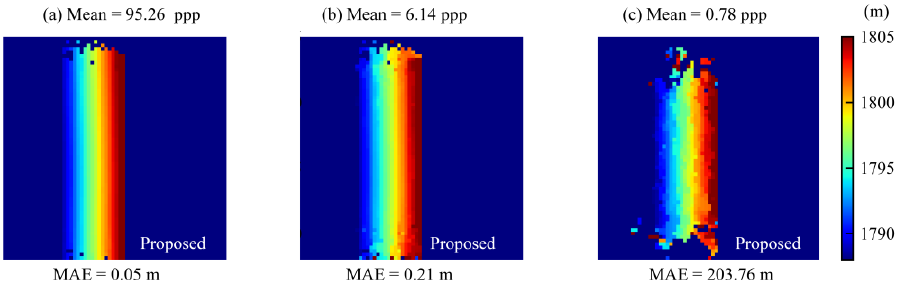
Figure 7. Comparison of depth imaging under different conditions for scene 3 at a distance of ~1.8 km. ( a ) The reconstructed 3D image with the signal photons of 95.26 ppp, ( b ) The reconstructed 3D image with the signal photons of 6.14 ppp, and ( c ) The reconstructed 3D image with the signal photons of 0.78 ppp.